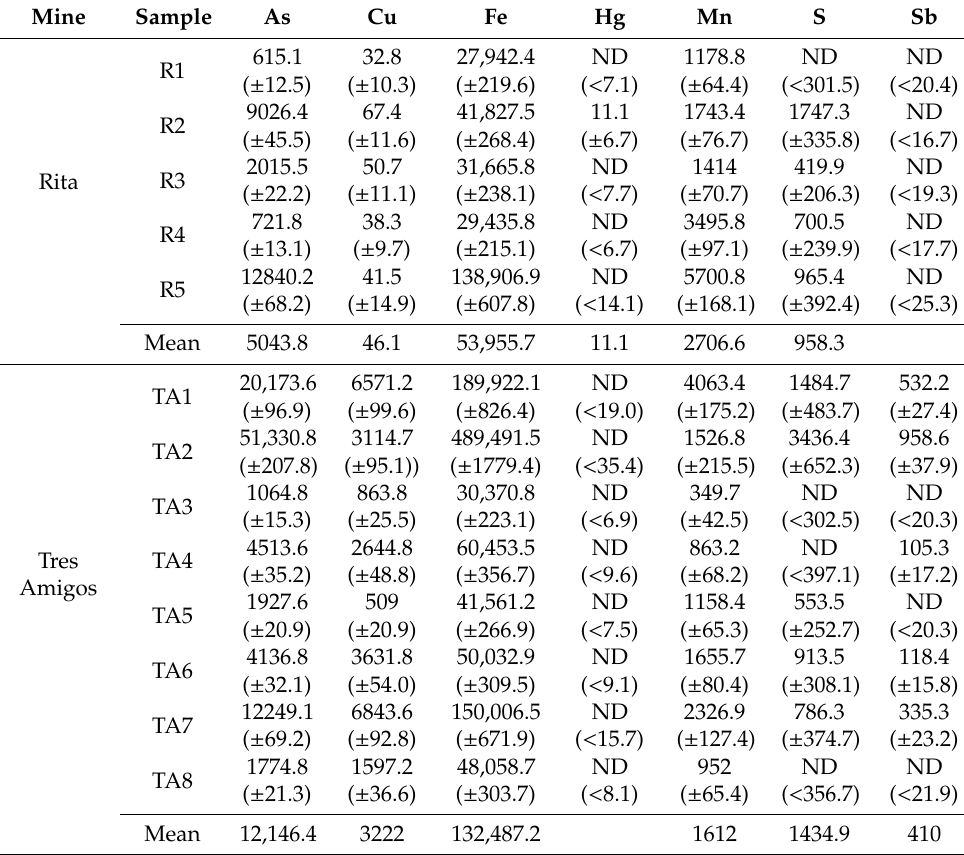
Table 1. Selected metal(loid)s content in soil samples (in mg / kg; ND: Not detected). Std deviation is indicated in brackets below each value. Reference value according to the less restrictive use of soil (industrial)